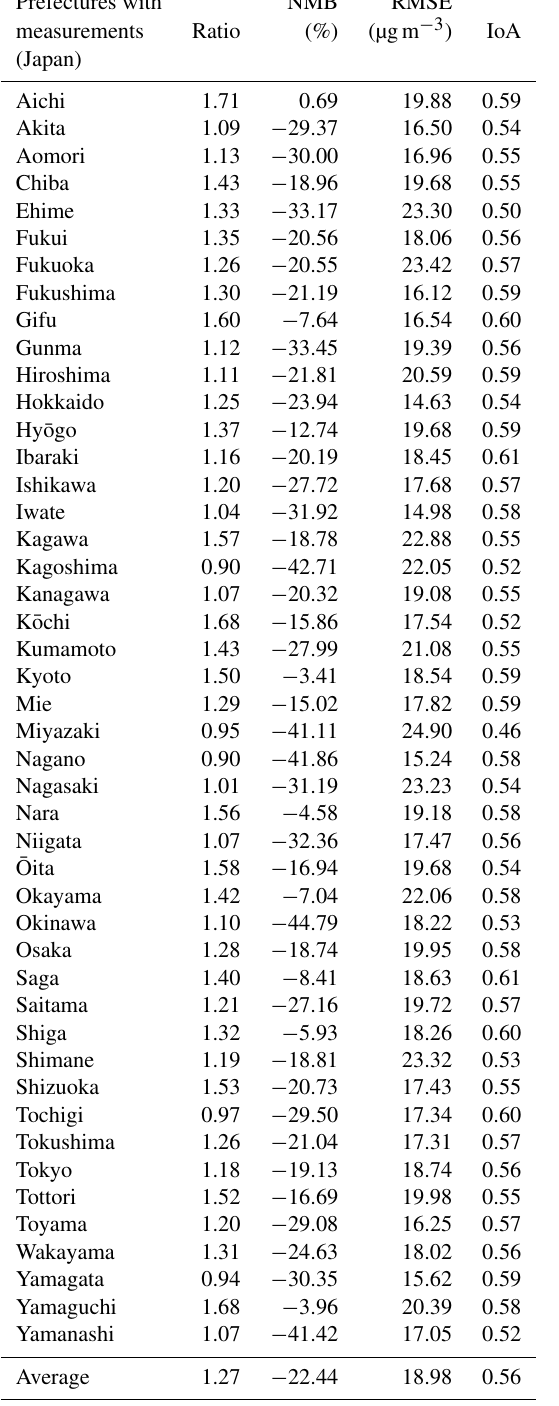
Table 2. Model evaluations of PM 10 across Japanese prefectures and South Korean provinces where measurements are available. NMB refers to normalized mean bias, RMSE refers to root mean square error, and IoA refers to index of agreement. We note that the evaluation of Japan was based on hourly data, while that of South Korea was based on monthly data.